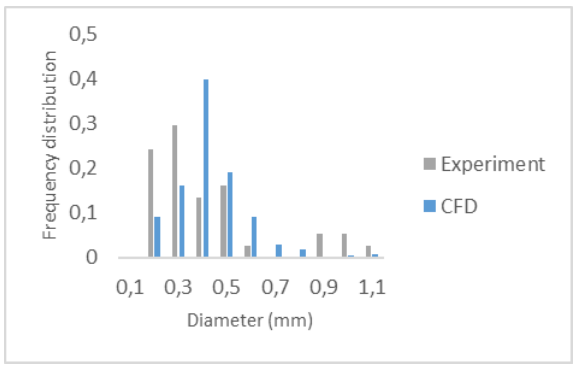
Fig. 6. Comparison of water droplet distribution in RPB